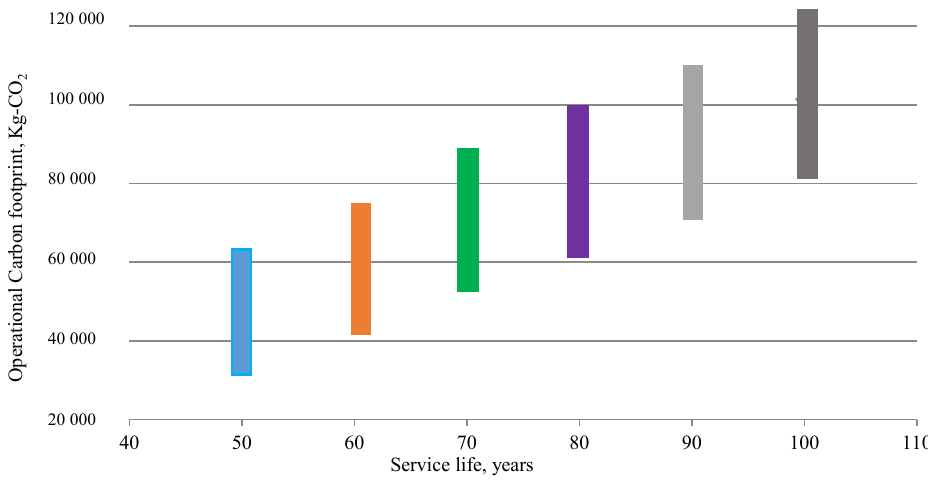
Fig. 3. Operational carbon footprint (kg-CO 2 ), 50–100 years of service